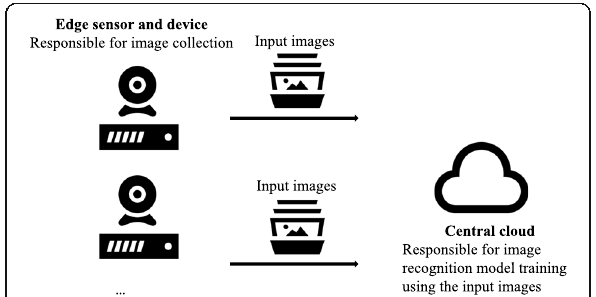
Fig. 4 Validation scenario: a cloud-Sensor System where the collected data is image data, and the learning mechanism on the central cloud is a neural network based learning